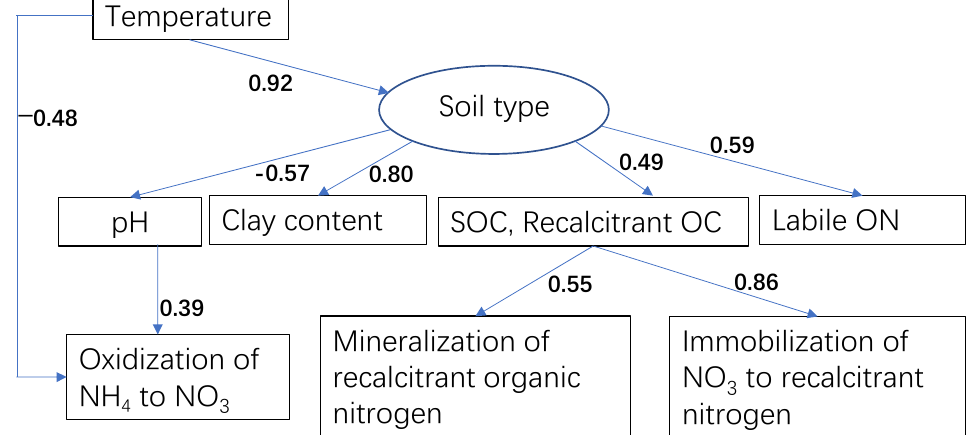
Figure 2. Partial least squares path model (PLS-PM) of the observed variables (measured) and latent variables (constructs). Path coefficients were calculated after 1000 bootstraps. Only significant path coefficients are shown in the figure ( p < 0.05). The statistical parameter (GoF, Goodness of Fit) was 0.74, which means the structural model predicted the correlations very well.